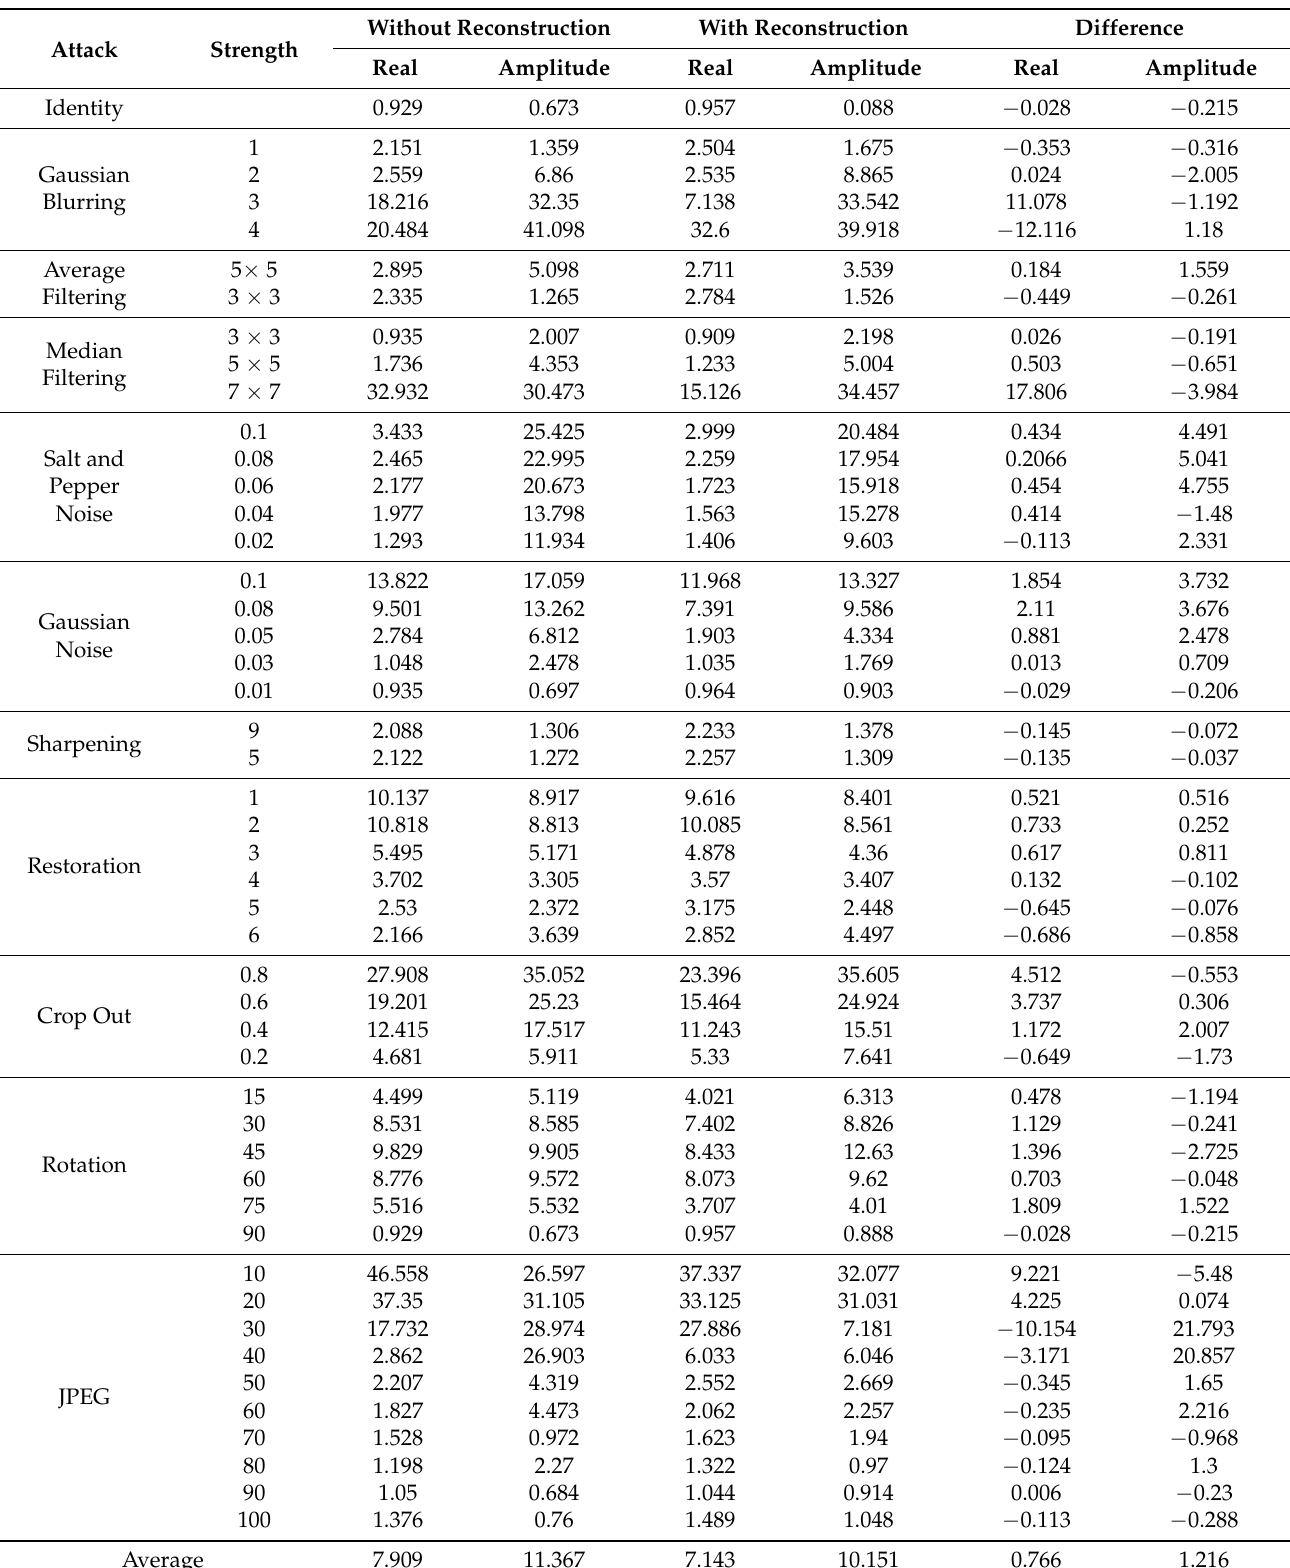
Table 4. Robustness result for the extracted watermark (average